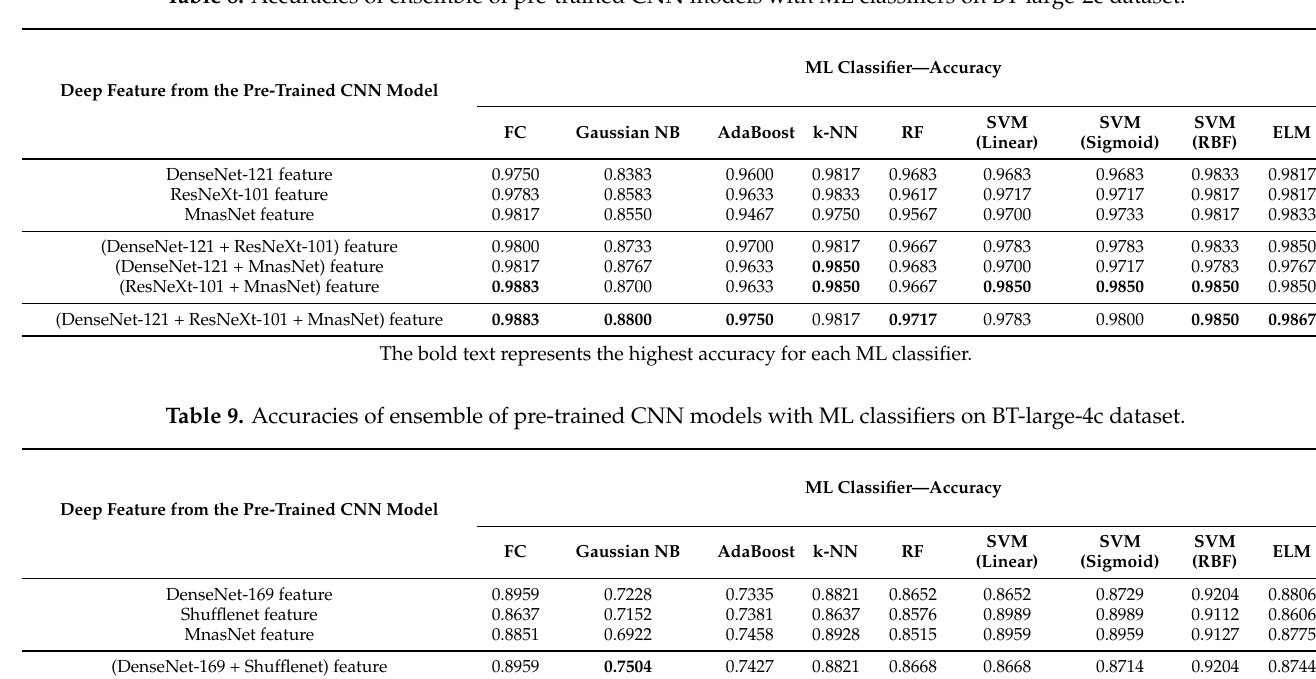
Table 8. Accuracies of ensemble of pre-trained CNN models with ML classifiers on BT-large-2c dataset.